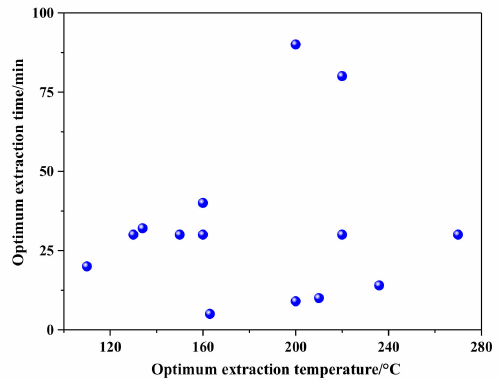
Figure 8. Optimum extraction conditions for organic